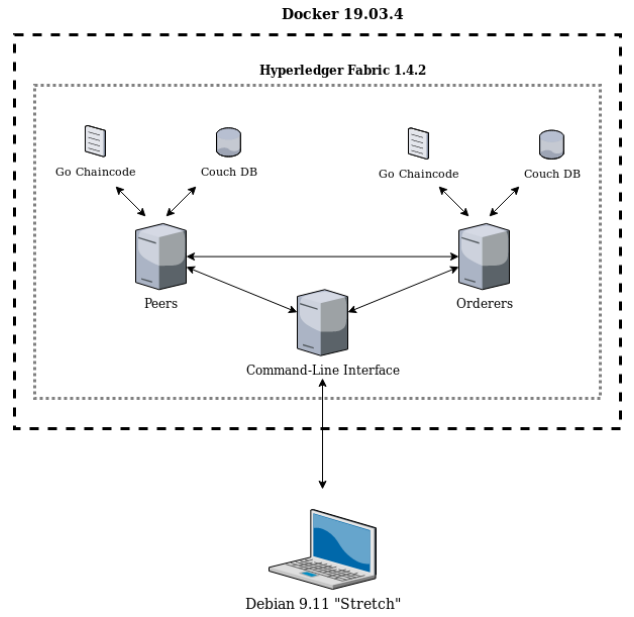
Figure 2. Proof-of-concept implementation overview.